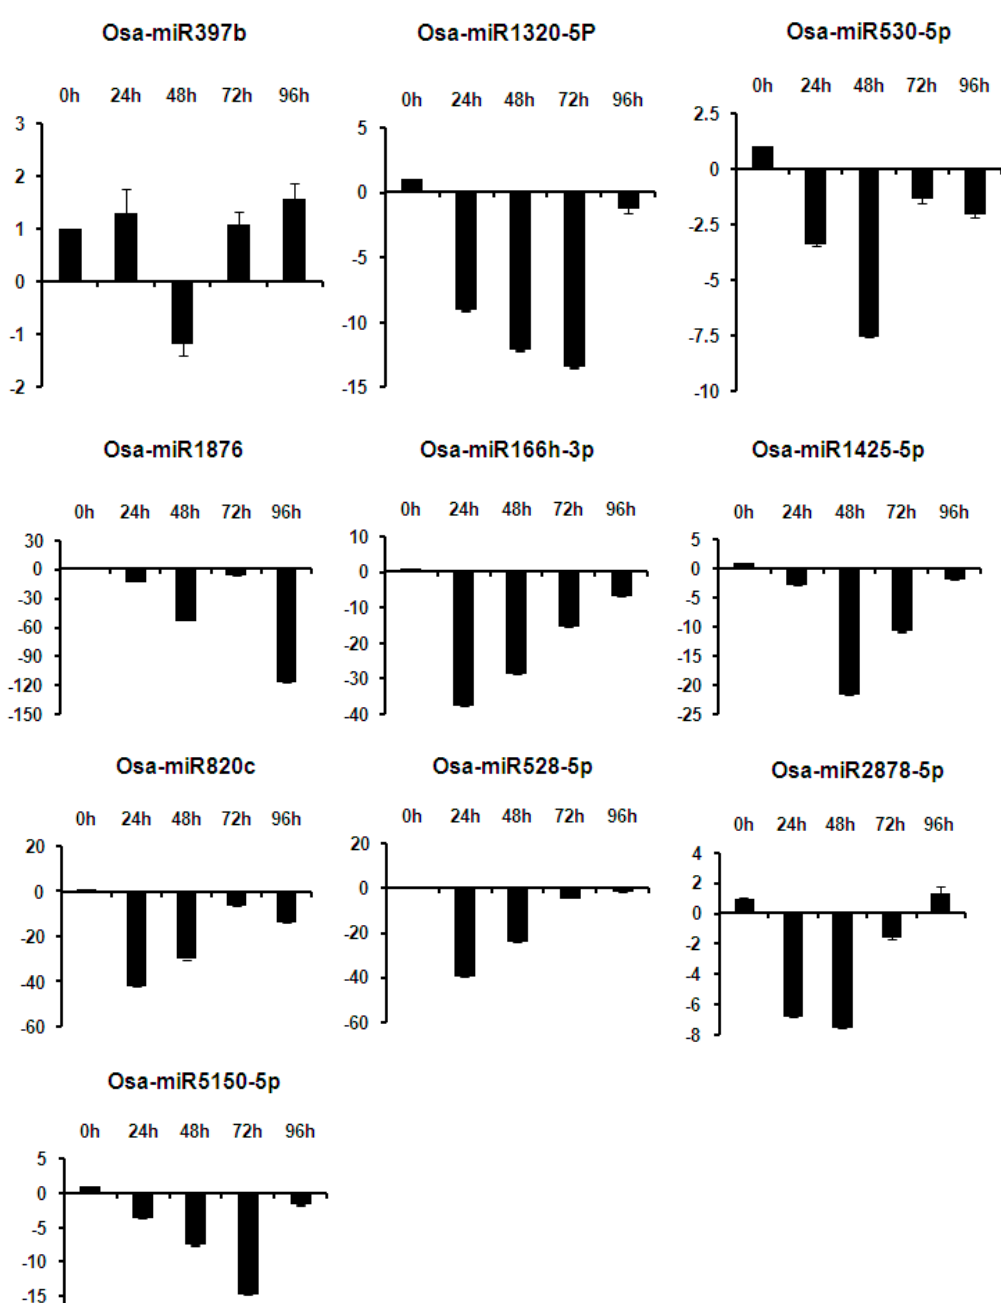
Figure 5. RT-qPCR expression analysis of miRNAs in the TN1 genotype at different time points after R. solani inoculation. Data is represented after internal reference gene U6 normalization. The error bars represent the standard error of three biological replicates. X -axis: samples and Y -axis: relative expression of miRNAs.